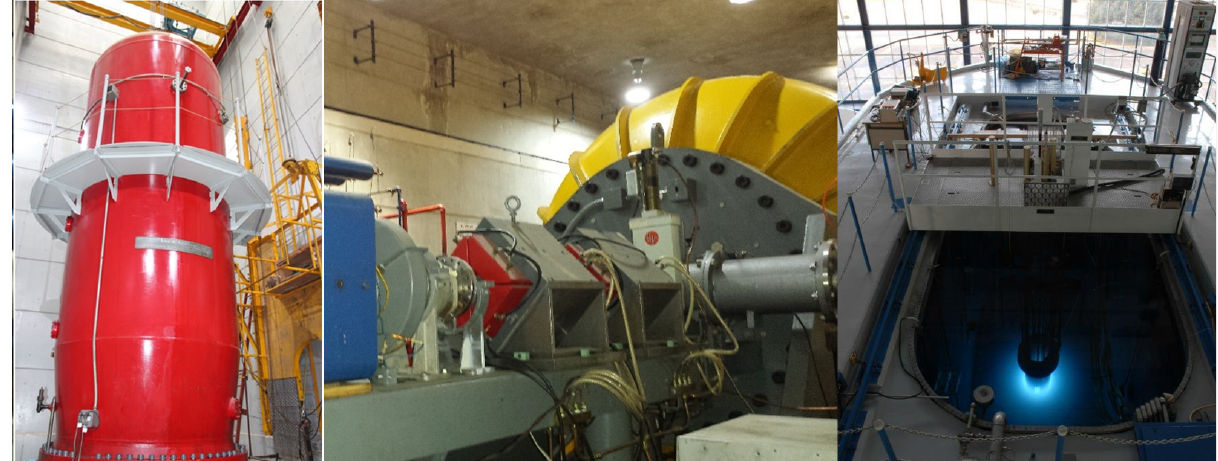
Figure 1. Mexican facilities used for the irradiation stage of the present studies. Left: 5.5 MV Van de Graa ff Accelerator, Carlos Graef Fernández Laboratory, IFUNAM, Mexico. Center: 6 MV Tandem Van de Graa ff Accelerator and Right: TRIGA Mark III Research reactor, both from the National Institute of Nuclear Research, Mexico.